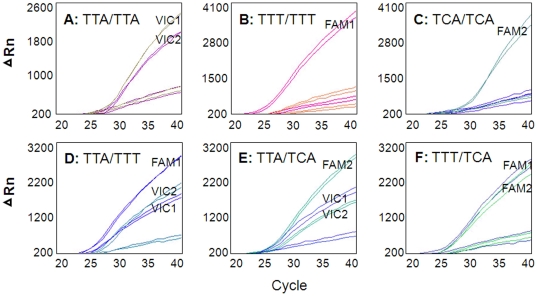
Real-time TaqMan method for genotyping kdr mutations at codon L1014 of para- sodium channel gene in Culex pipiens pallens.Genotype of specimens: A (TTA/TTA); B (TTT/TTT); C (TCA/TCA); D (TTA/TTT); E (TTA/TCA); and F (TTT/TCA).